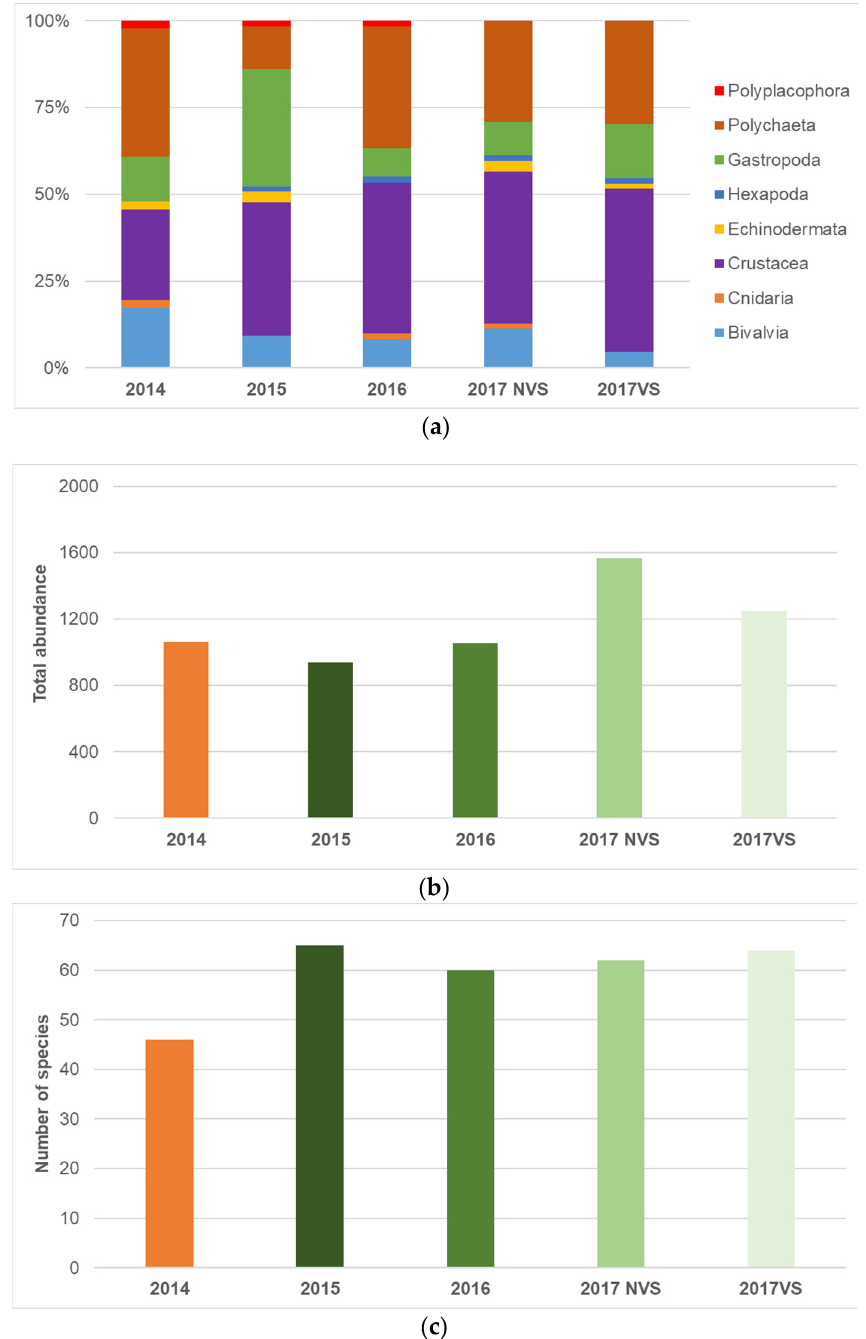
Figure 2. ( a ) Distribution of collected species in the most represented taxa; ( b ) total abundance and ( c ) number of species from 2014 ante transplant operations to 2017 post-transplant operations (vegetated –VS- and non-vegetated stations –NVS-).